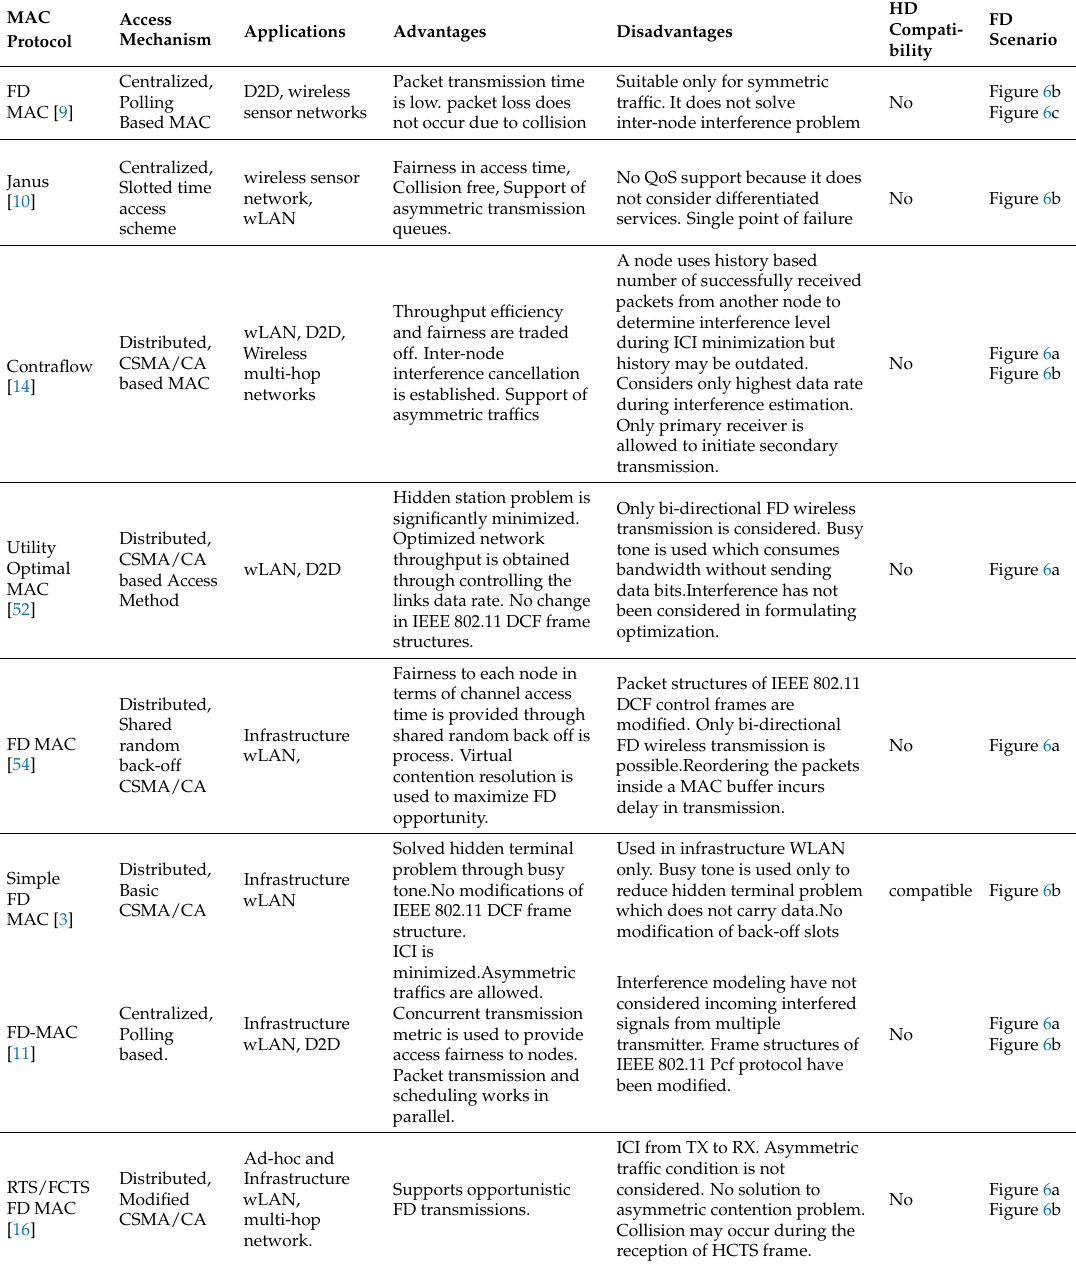
Table 3. Qualitative comparison of existing full duplex (FD) MAC